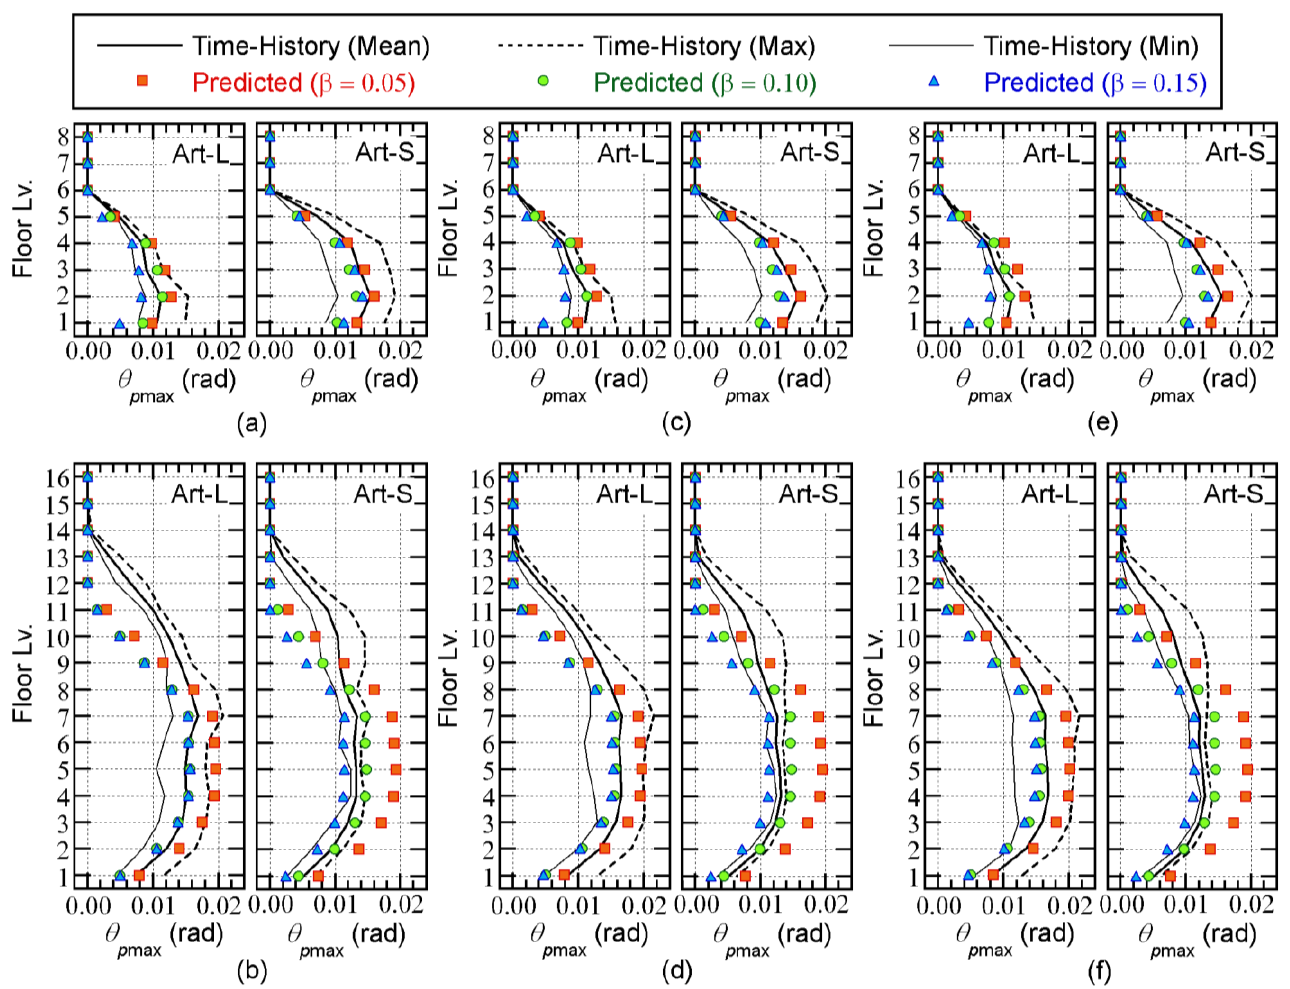
Figure 13. Comparisons of the peak plastic hinge rotation of the beam: ( a ) 8-story model ( h 1 f = 0.00); ( b ) 16-story model ( h 1 f = 0.00); ( c ) 8-story model ( h 1 f = 0.03); ( d ) 16-story model ( h 1 f = 0.03); ( e ) 8-story model ( h 1 f = 0.05); ( f ) 16-story model ( h 1 f =